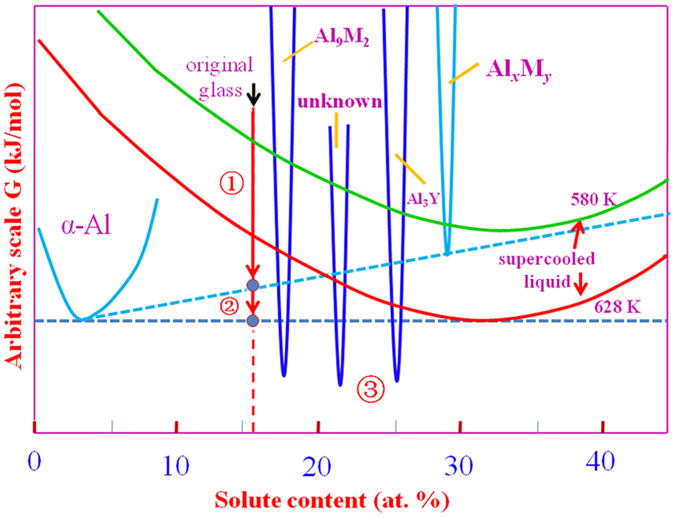
The relative free energies of the phases relevant for the crystallization of Al84Y9Ni4Co1.5Fe0.5Pd1 glass. In this schematic figure, the alloy is treated as a binary (Al + solute) system. The primary (arrow 1) and secondary (arrow 2) crystallization reactions are shown; ultimately (point 3) the stable phases are attained on heating.